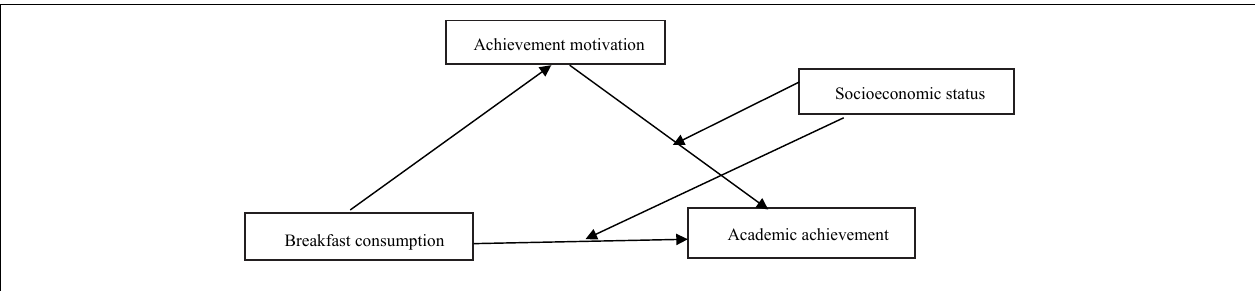
FIGURE 1 | Conceptual